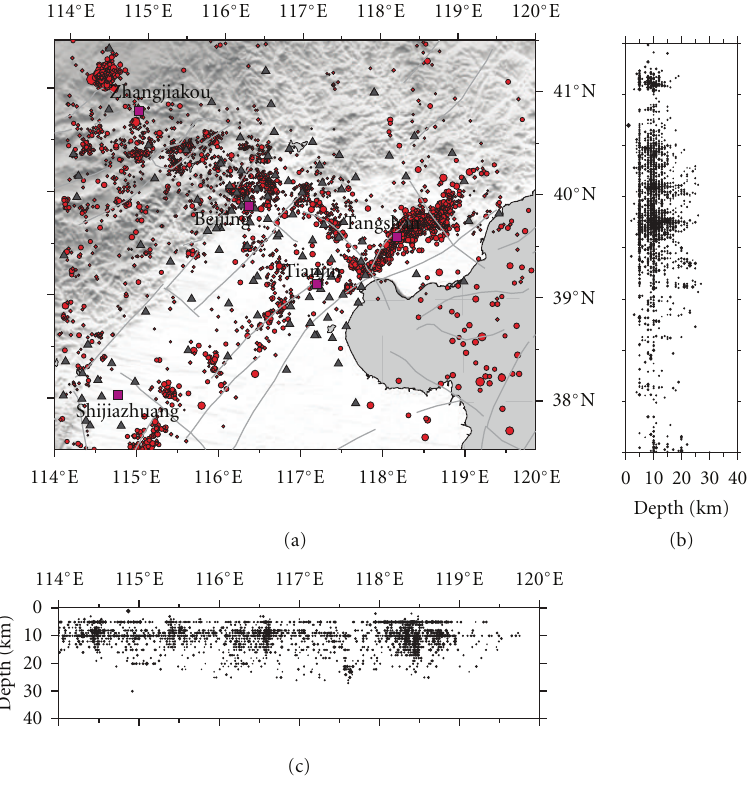
Figure 2: Distribution of seismic stations and earthquake hypocenters used in this study. (a) shows distribution of earthquake epicenters (circles) and seismic stations (triangles). Squares show the major cities. Thick lines denote active faults; (b) and (c) show the cross sectional view of focal depth along latitude and longitude profiles, respectively.